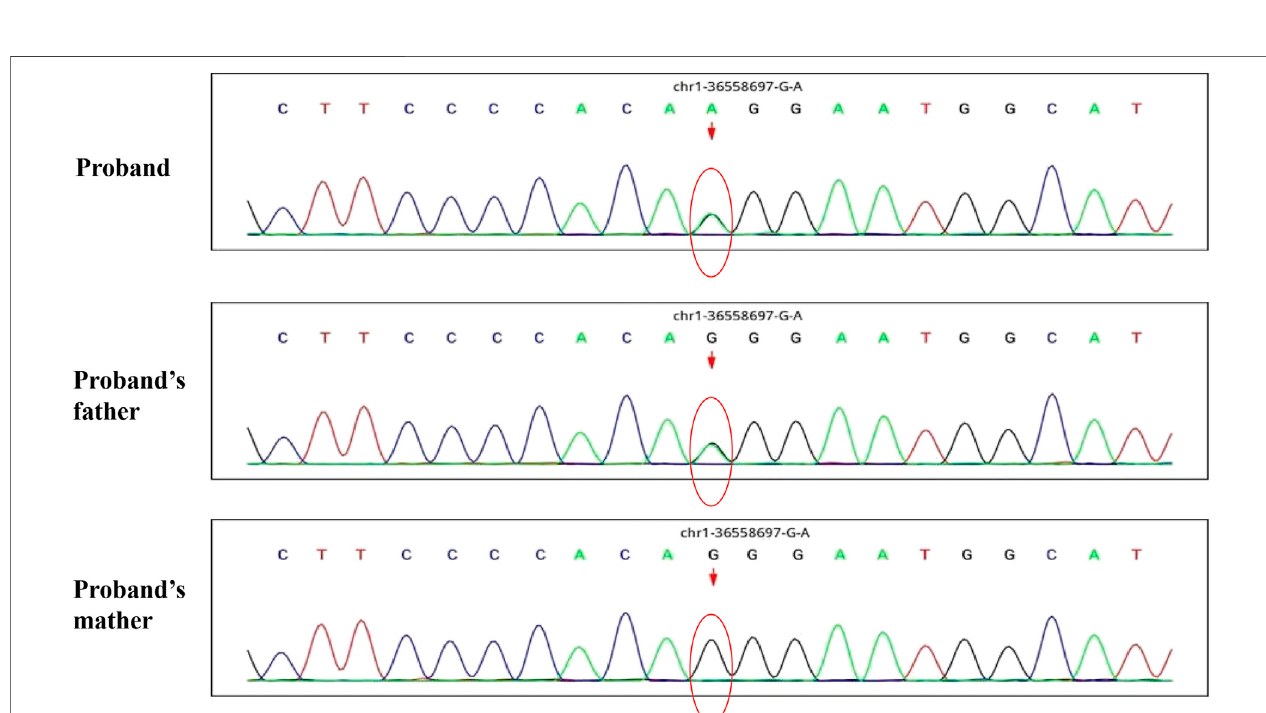
FIGURE 2 | The whole exon sequence of C.803-1G > A in this child patient and his parents.